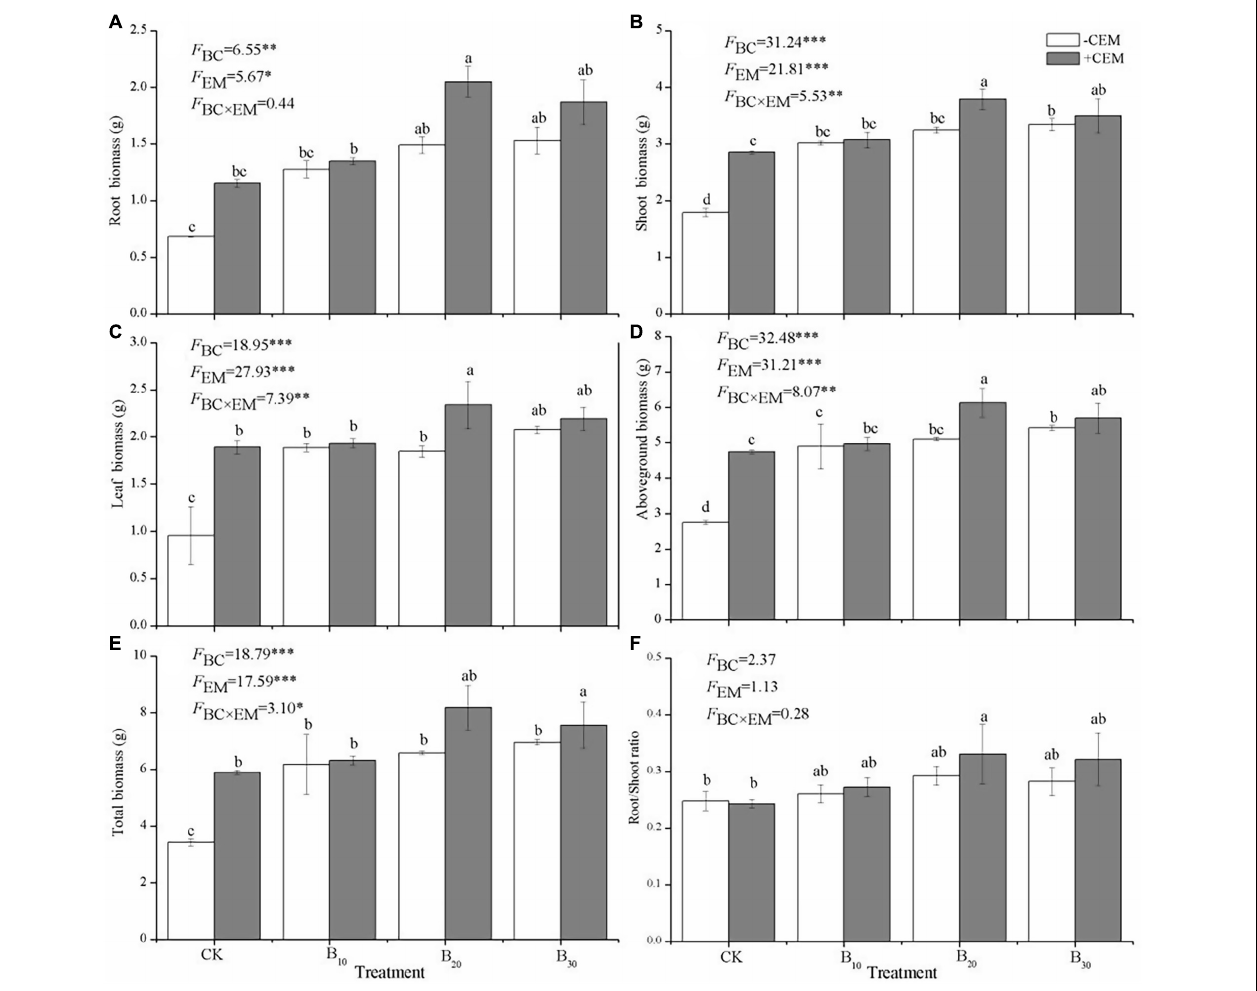
FIGURE 2 | Root biomass (A) , shoot biomass (B) , leaf biomass (C) , aboveground biomass (D) , total biomass (E) , and root/shoot ratio (F) under different treatments. Different lowercase letters referred to significant difference between treatments ( p < 0.05). The F BC , F CEM , and F BC × CEM are F and the degree of freedom of two-way ANOVAs. ∗∗∗ p < 0.001, ∗∗ p < 0.01, ∗ p <